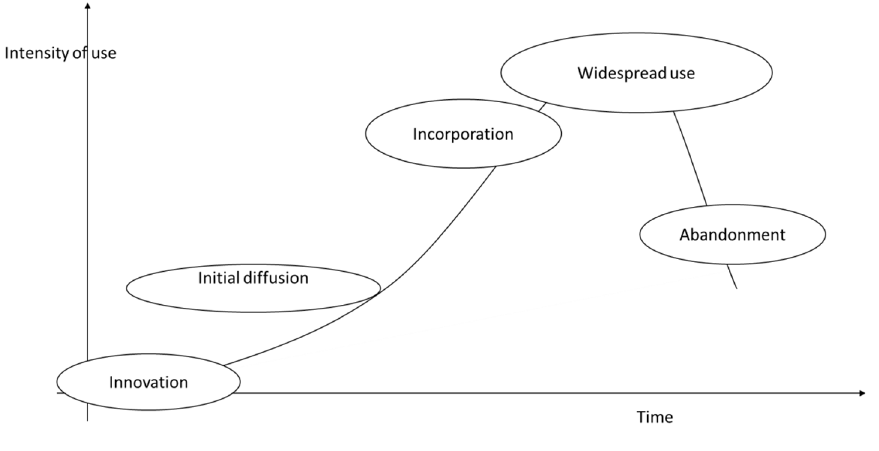
Figure 1. Life cycle of health technology and innovation